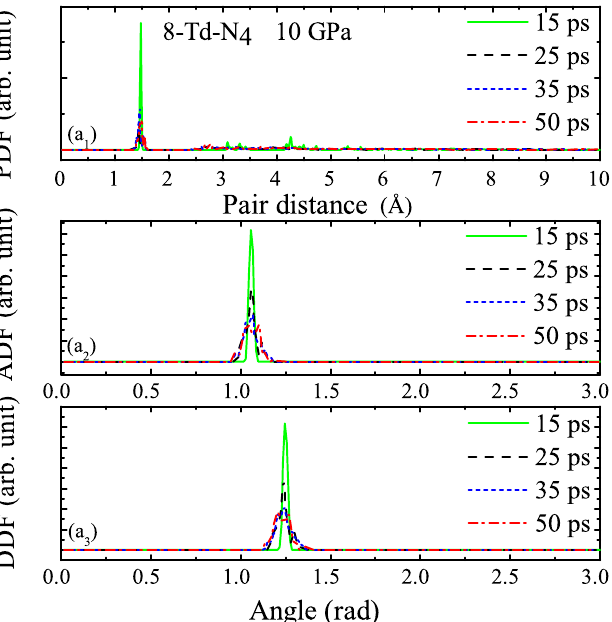
Figure 13. ( a 1 – a 3 ) Pair distribution functions at 15, 25, 35, and 50 ps under 10 GPa in the MD